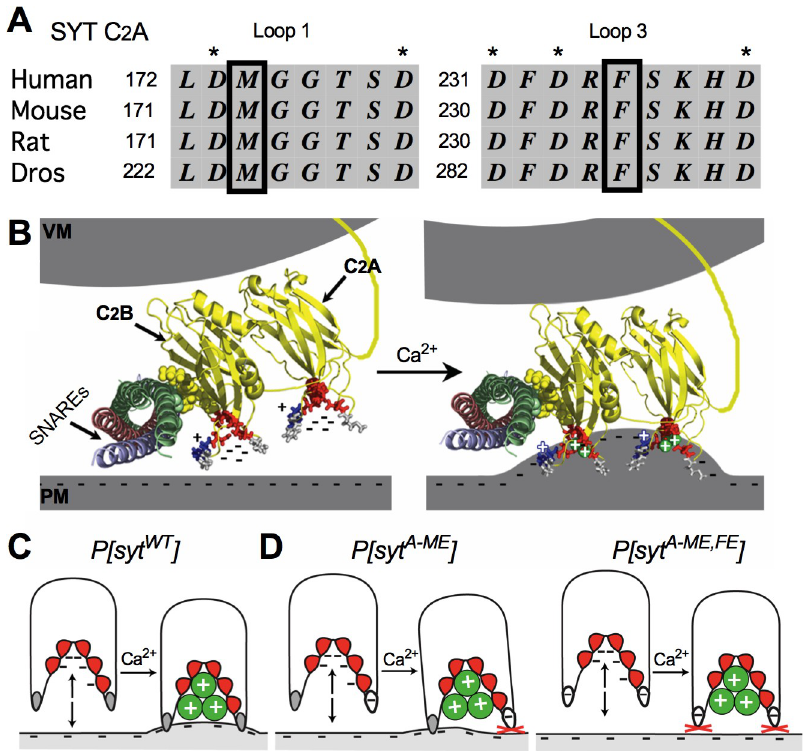
Fig 1. Synaptotagmin structure and C 2 A mutations. A, Protein alignment of loops 1 and 3 of the C 2 A domain of synaptotagmin 1 from Human, Mouse, Rat, and Drosophila ( � = Ca 2+ binding aspartates, boxes = loop 1 and loop 3 hydrophobic tip residues) B, Crystal structure of synaptotagmin and the SNARE complex showing a postulated role of the C2 domains in triggering fusion, adapted from [19]. Negatively charged residues of the Ca 2+ binding pockets are shown as sticks in red, the hydrophobic residues at the tips of these pockets are shown as sticks in gray, and Ca 2+ ions are shown as green spheres. VM = vesicle membrane and PM = presynaptic membrane. C, A cartoon depiction of the C 2 A domain. Colors as in panel B. D, Hydrophilic glutamic acid substitutions are indicated in white. Sequential mutation of C 2 A hydrophobic tip residues to hydrophilic residues is predicted to increasingly disrupt synaptotagmin’s ability to penetrate, warp and disorder lipids of the presynaptic membrane.